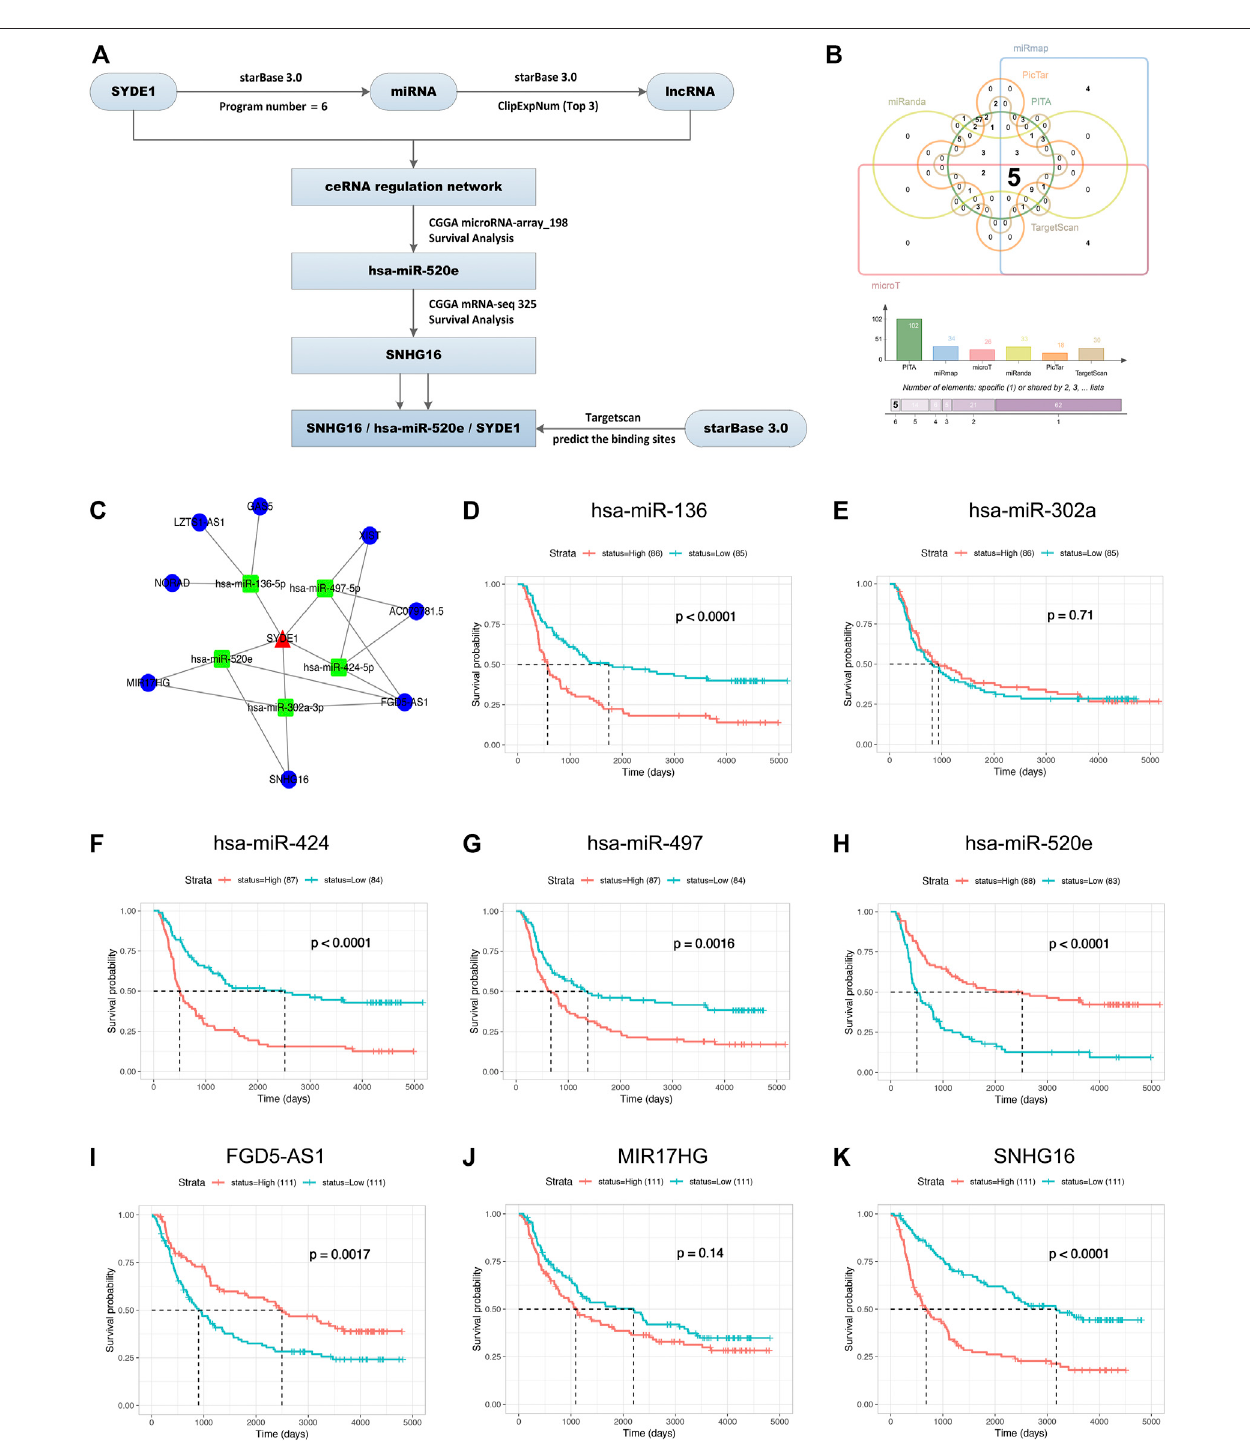
FIGURE 10 | Prediction of SYDE1 -targeted miRNAs and lncRNAs. (A) A schematic overview of different steps taken to predict SYDE1 -targeted miRNA and lncRNA. (B) Upsetplotshowingthenumberofpredicted SYDE1 -targeted miRNAs. (C) Networkof SYDE1- targeted miRNAsand lncRNAs. (D – H) Kaplan-Meier survival curves for 5-miRNA signature. has-miR-136 (D) , has-miR-424 (F) , has-miR-497 (G) and has-miR-520e (H) are positively associated with OS, whereas has-miR-302a (E) is not associated with OS. (I – K) Kaplan-Meier survival curves for 3-lncRNA signature. FGD5-AS1 (I) , MIR17HG (J) and SNHG16 (K) are positively associated with